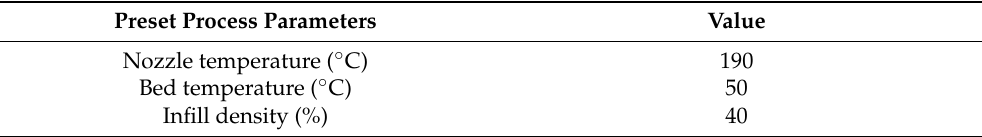
Table 4. Preset process parameters for coupon fabrication.